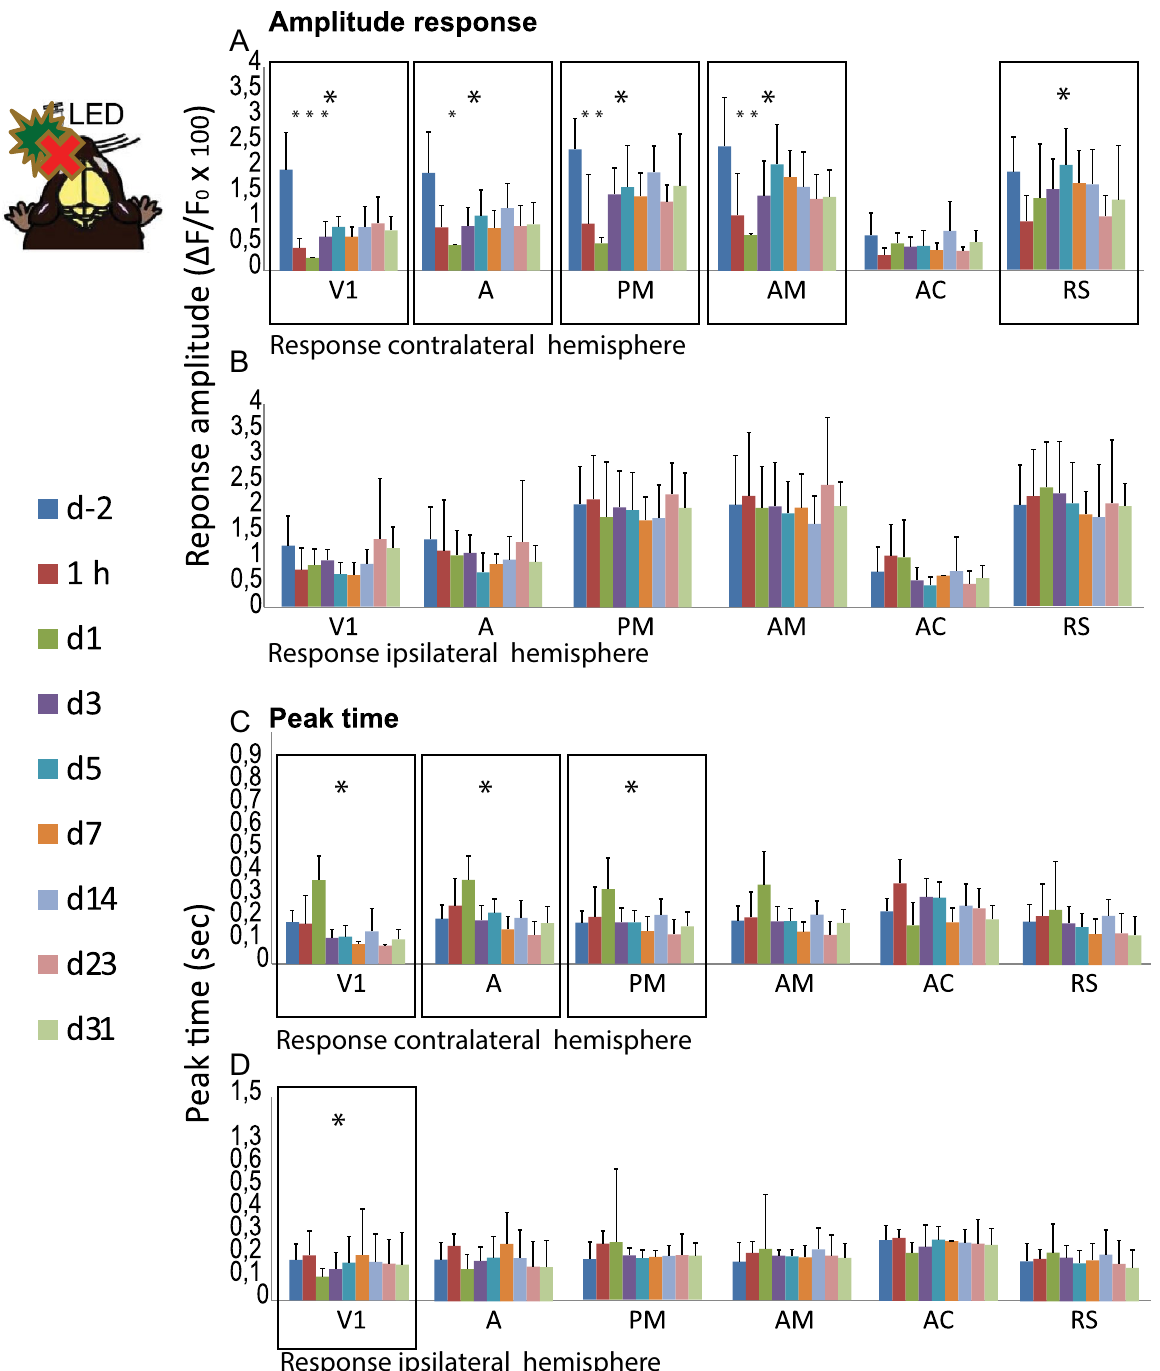
Figure 2. Cortical responses following optic nerve injury. Upper panel for amplitude and lower panel for peak response. ( A) Cortical peak response (ΔF/F 0 × 100) in the contralateral hemisphere to the flash stimulation in the injured eye. ( B) Cortical peak response (ΔF/F 0 × 100) in the ipsilateral hemisphere to the flash stimulation in the healthy eye. ( C ) Peak latency in the contralateral hemisphere to the flash stimulation in the injured eye. ( D) Peak latency in the ipsilateral hemisphere to the flash stimulation in the healthy eye. (*) Indicates Kruskal Wallis test, which provided p values under 0.05. V1 primary visual cortex; A, AM, PM anterior, anteromedial, and posteromedial regions of the secondary visual cortex; AC anterior cingulate cortex; RS retrosplenial